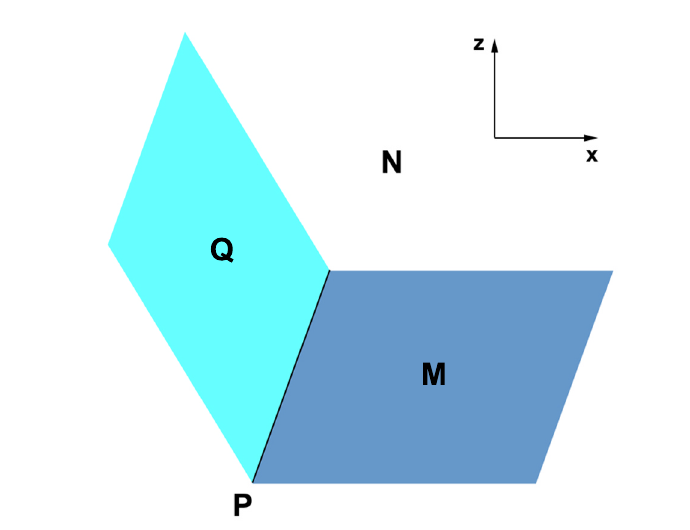
Figure 1 . Geometry of AdS/BCFT, where M is a d-dimensional manifold with a boundary P = ∂M , N is (d+1)-dimensional AdS space bounded by M and Q , i.e., ∂N = M ∪ Q . AdS/BCFT proposes that the gravity theory in the bulk N is dual to the BCFT on the AdS boundary M